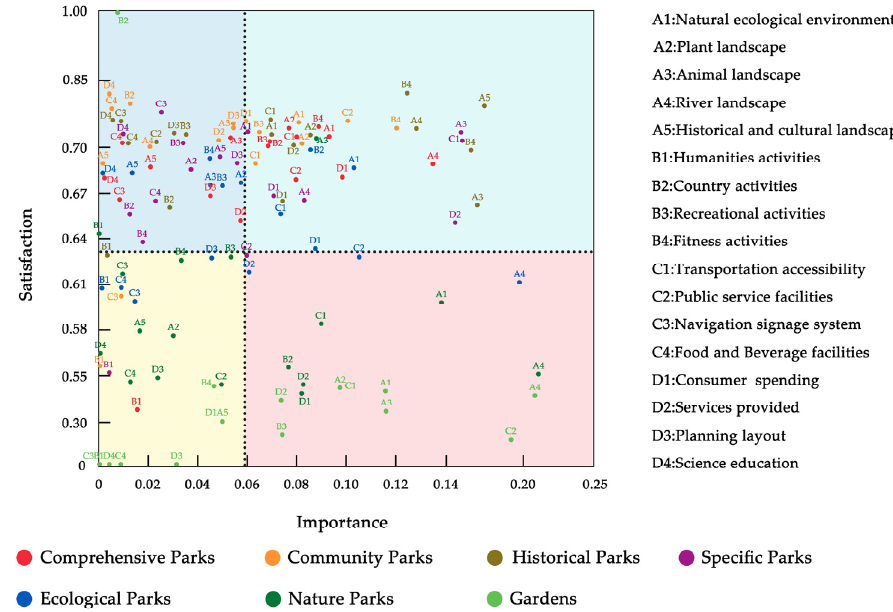
Figure 9. IPA model of riverside parks of different types based on spatial landscape design.